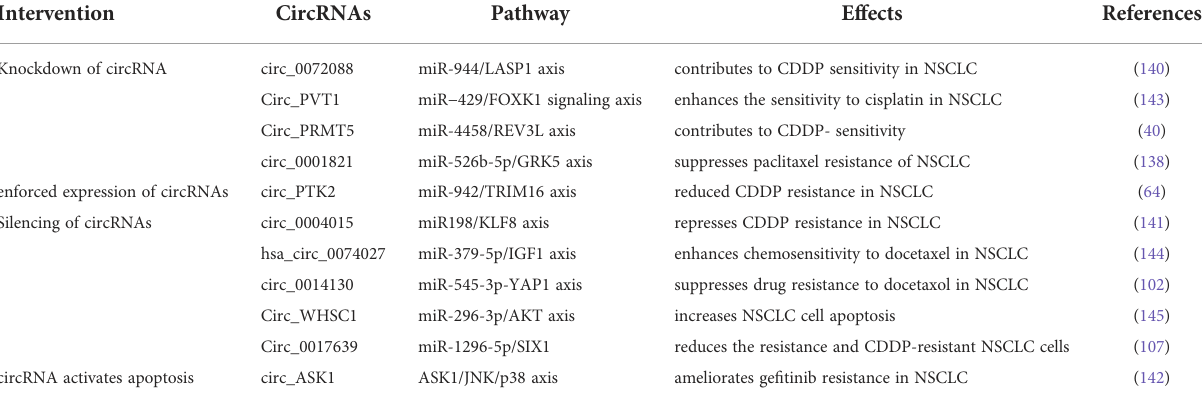
TABLE 3 CircRNAs as potential therapeutic targets for overriding drug resistance in